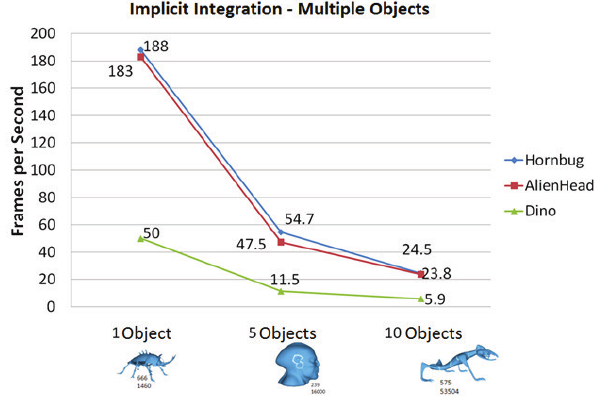
Figure 5. Point Based Animation meshless particle technique: a sequentially executed scene (Intel Core i7) containing one object (577 physical and 53,504 surface elements) simulating a Verlet explicit integration obtained rates of 4.1 fps, while in the parallel implementation (GTX 295) ten instances of the same object simulating an Eulerian implicit integration obtained rates of 6